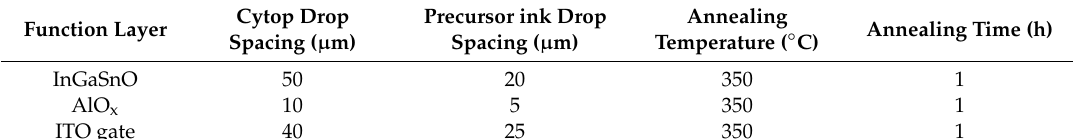
Table 1. Processing Parameters of TFT Fabrication.